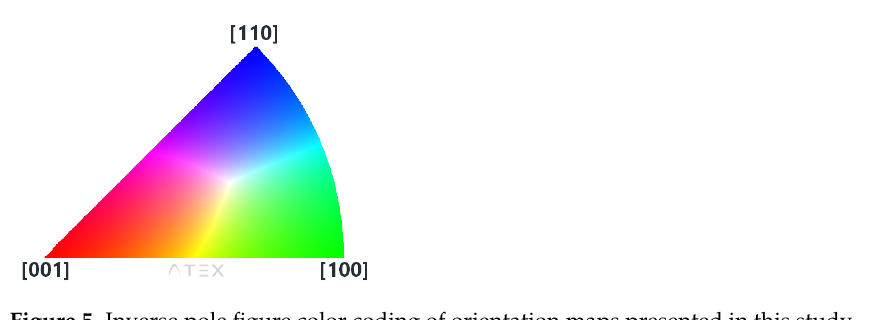
Figure 5. Inverse pole figure color coding of orientation maps presented in this study.